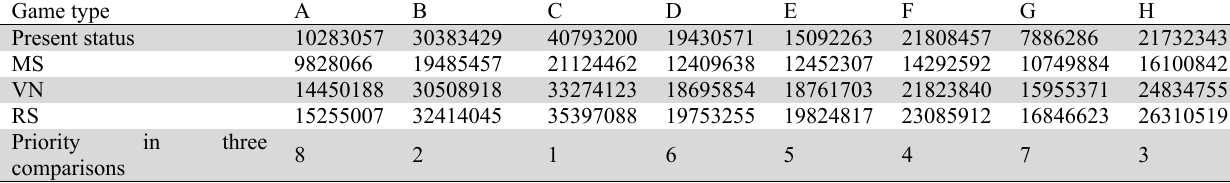
Prioritization of manufacturers based on distributor’s